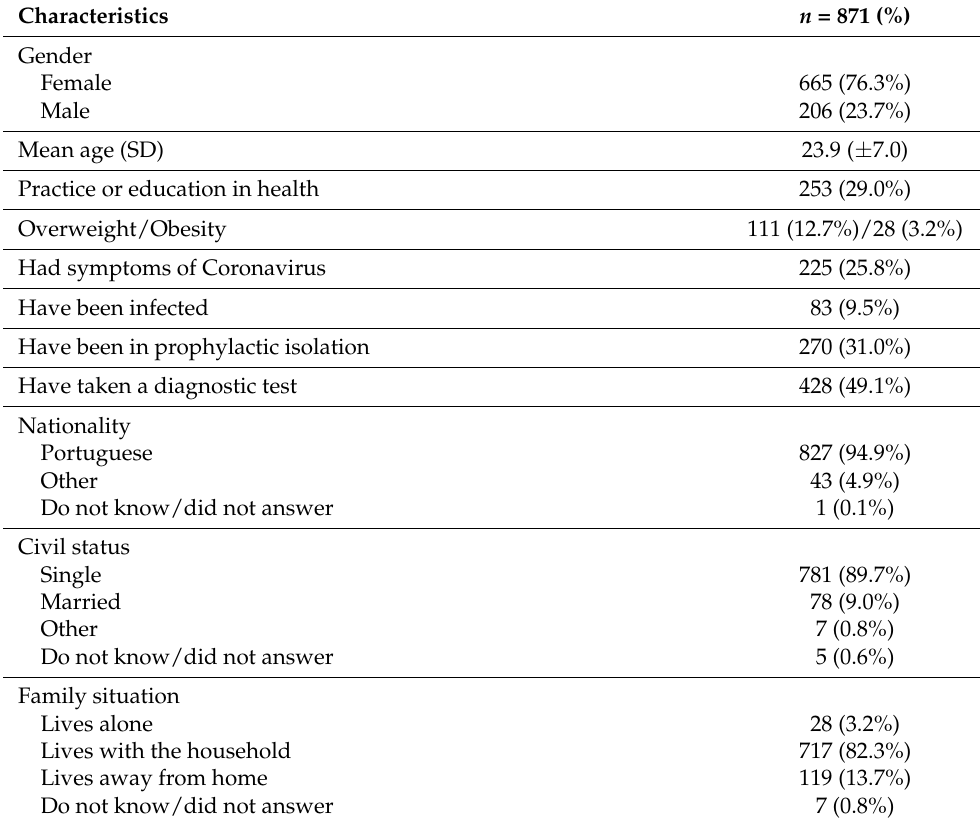
Table 1. Sociodemographic